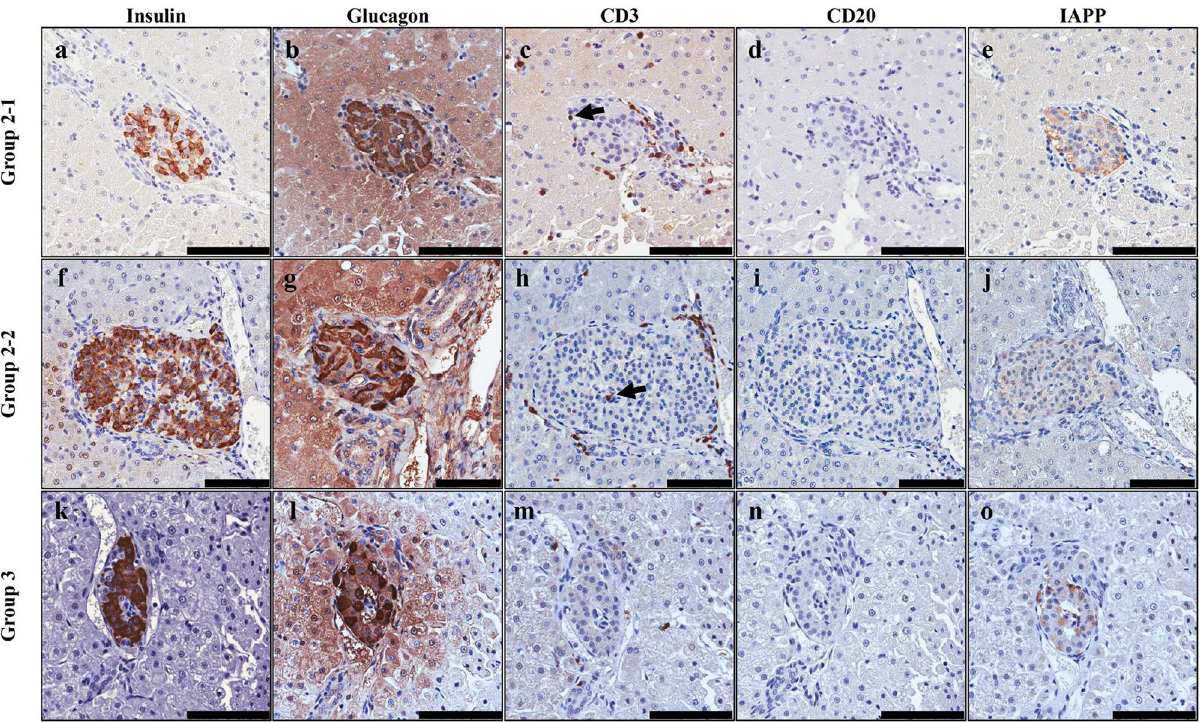
Figure 4. Representative results from the immunohistochemical analysis of islets found in liver biopsies conducted one month after transplantation. Liver biopsies were performed in group 2-1 ( a – e ), group 2-2 ( f – j ), and group 3 ( k – o ). In Group 1, no liver biopsies were performed due to the subjects’ poor health caused by high blood glucose levels. Insulin ( a,f , k ) and glucagon ( b , g , i ) were expressed in high amounts within the islets of groups 2-1, 2-2 and 3. Small numbers of CD3 + T cells (arrowed) ( c , h , m ) and CD20 + B cells ( d , i , n ) were detected in the islet areas of both groups 2-1, 2-2 and 3, but they were higher in both group 2-1 and 2-2. IAPP ( e , j , o ) was slightly expressed in all parts of the islets. Brown indicates the target protein in each result (scale bars = 100